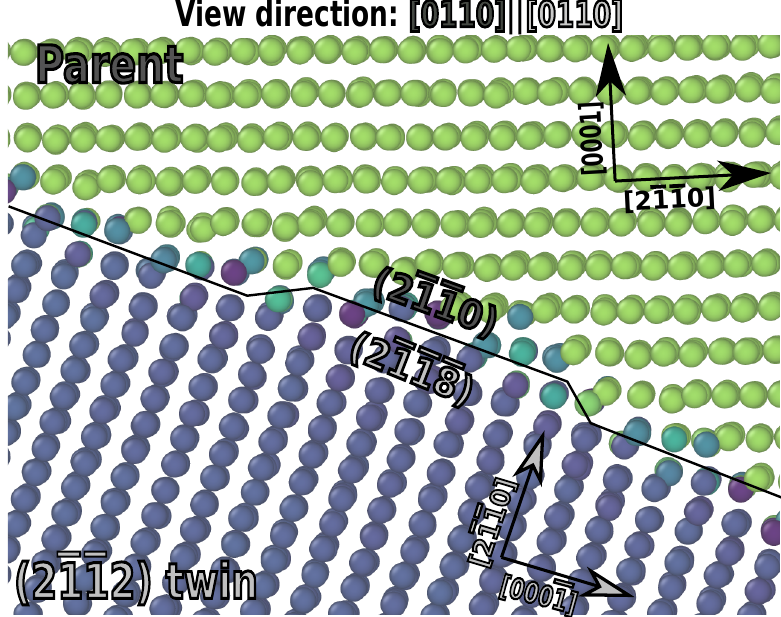
Figure 4. ( 2112 ) facet onto the ( 2118 ) || ( 2110 ) interface. A mobile one-layer step is visible on the